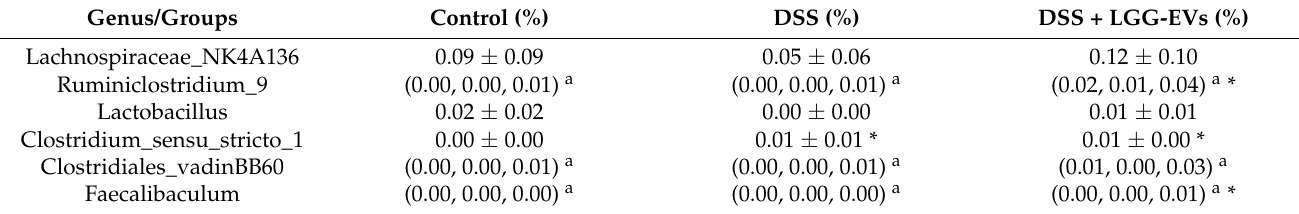
Table 7. Relative abundance of bacteria classical producer for short-chain fatty acids at the genus level ( n = 5).